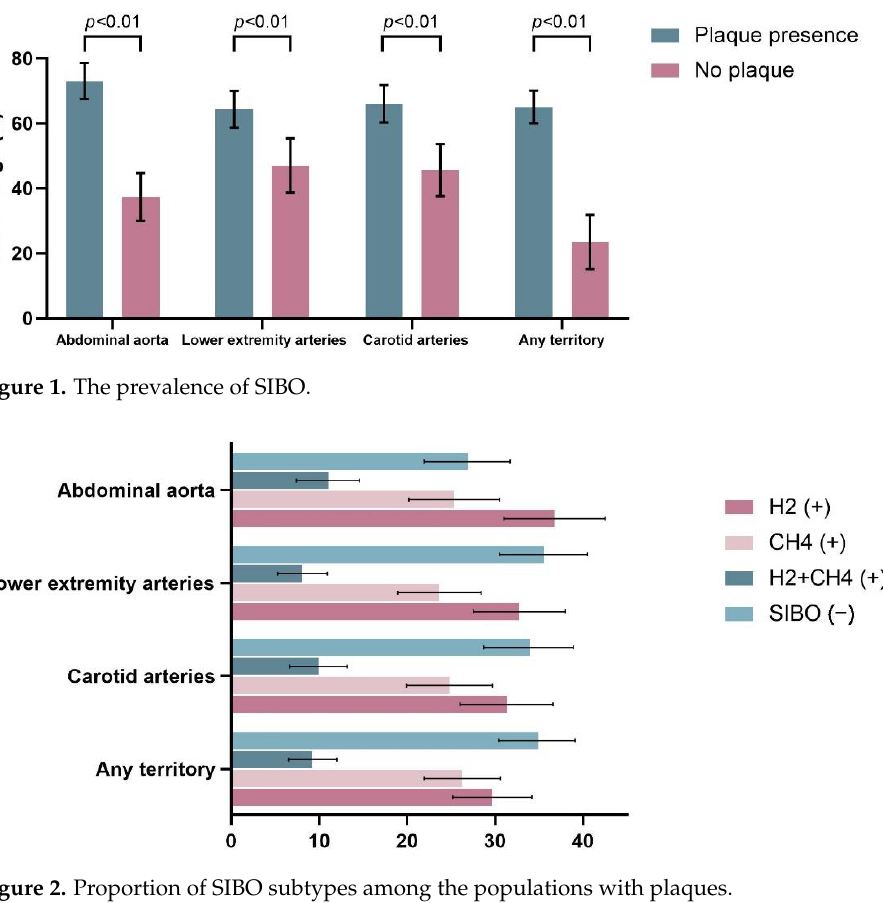
Figure 2. Proportion of SIBO subtypes among the populations with plaques. As shown in Table 2, bloating was the most common of all investigated symptoms Table 2. Comparison of gastrointestinal symptoms between the SIBO-positive and SIBO-negative (248/411, 60.3%). Among the symptoms investigated, bloating ( p < 0.01), loss of groups.